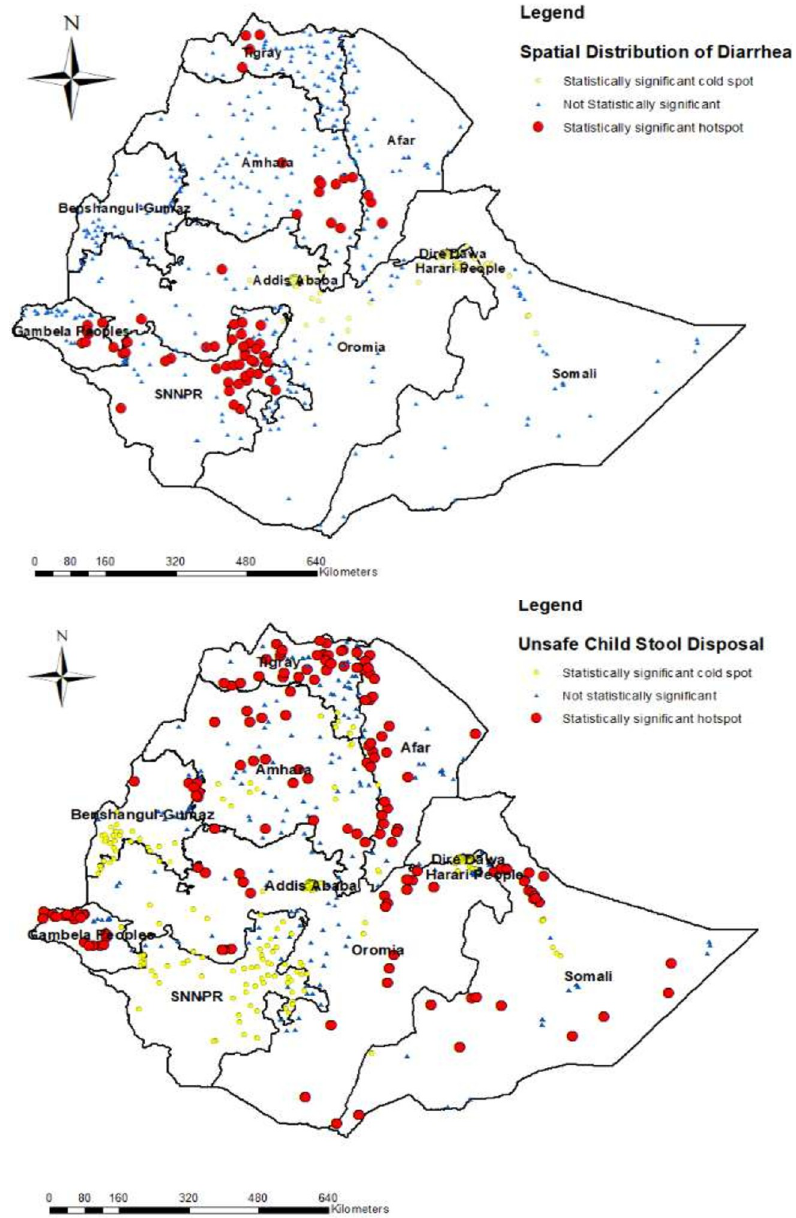
Fig 4. The exploratory visualization of the spatial distribution diarrhea and unsafe child stool disposal. (a) map at upper section showed the spatial distribution diarrhea (b) map at lower section showed the spatial distribution of unsafe child stool disposal, EDHS 2016. Source: Shapefile of the map was freely available from https://africaopendata. org/dataset/ethiopia-shapefiles. (West, and South), Amhara (Central, North, and Southeast), Gambela (West), Oromia (East), North and some parts of Somali regions. The possible explanation for geographic variation in the prevalence of unsafe child stool disposal might be due to high open defecation practice in these identified hot spot areas. According to EDHS-2016 report, one in three households in Ethiopia have no toilet facility (39% in rural areas and 7% in urban areas) and open defecation